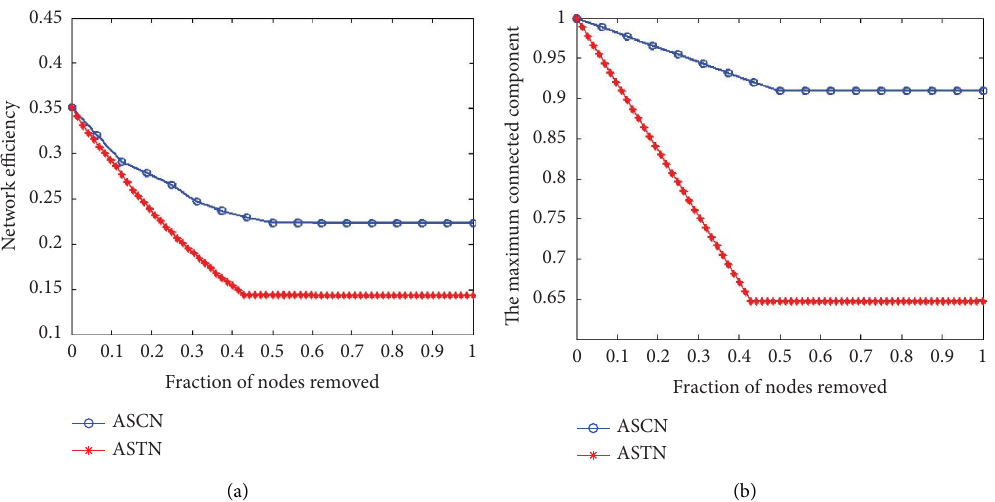
Figure 15: Te robustness of ACMN under noncascading failure. (a) Network efciency (noncascading). (b) Maximum connected component